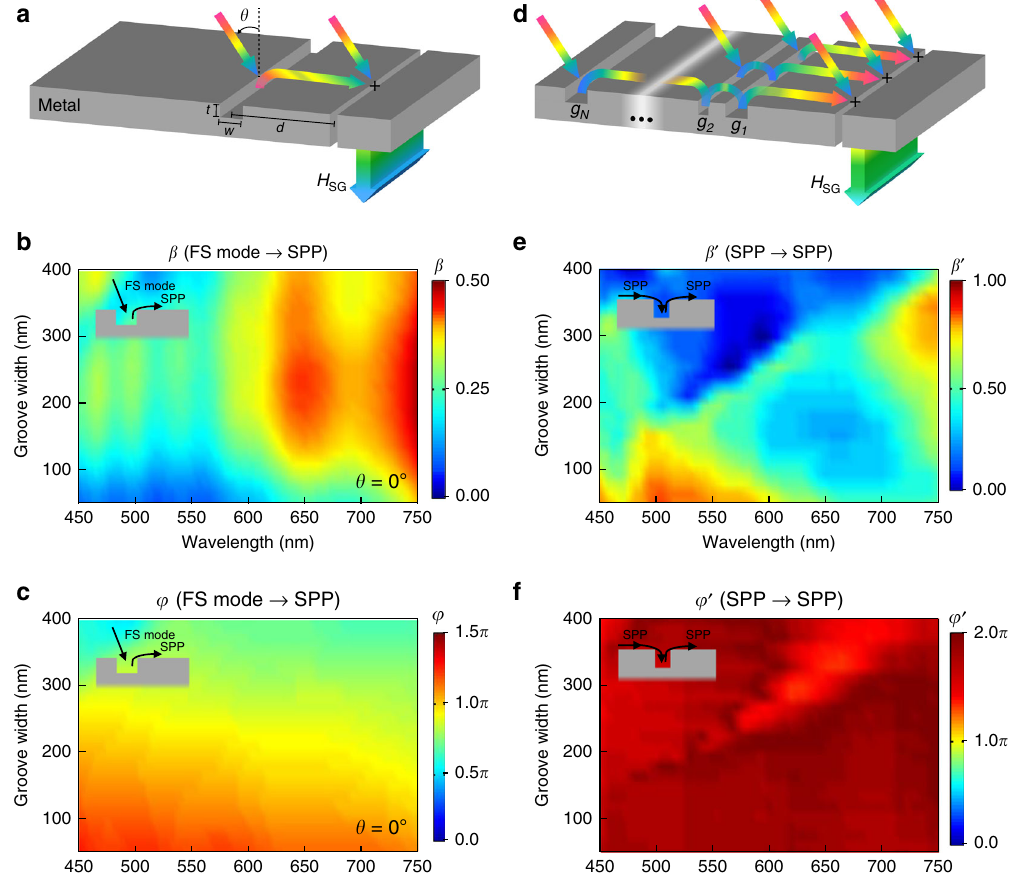
Fig. 1 Transmission mechanism through an aperiodic slit-groove device. a H - fi eld amplitude transmission from a slit in the presence of a single-groove placed to its left, illuminated by a TM polarized white light laser ( H - fi eld parallel to the slit-length) at an angle θ on a metal-dielectric interface, where d is the distance between the slit and the groove (of width w and depth t ). The SPP coupling process at the location of the groove is characterized by a real coupling coef fi cient β and phase φ . b , c Variation in β and φ as a function of both groove-width ( w : 50 – 400 nm) and free-space wavelength ( λ 0 : 450 – 750 nm), for illumination at normal incidence ( θ = 0°) and fi xed groove-depth ( t = 100 nm) at a Ag-air interface. d H - fi eld amplitude transmission through a device consisting of N grooves located to the left of an isolated slit. The propagation of an SPP coupled from an arbitrary groove g N propagating over an intermediate groove on its way to the slit undergoes a phase-shift φ ′ and an amplitude reduction of a factor β ′ . In both a , d the superimposed guided-mode propagation, through the slit, of both the free-space light and the SPP is characterized by a relative H - fi eld coupling coef fi cient B eff and phase- shift Φ eff (Supplementary Fig. 2). e , f Variation in β ′ and φ ′ as a function of groove-width ( w : 50 – 400 nm) of an intermediate groove, and free-space wavelength ( λ 0 : 450 – 750 nm), and fi xed groove-depth ( t = 100 nm) at a Ag-air